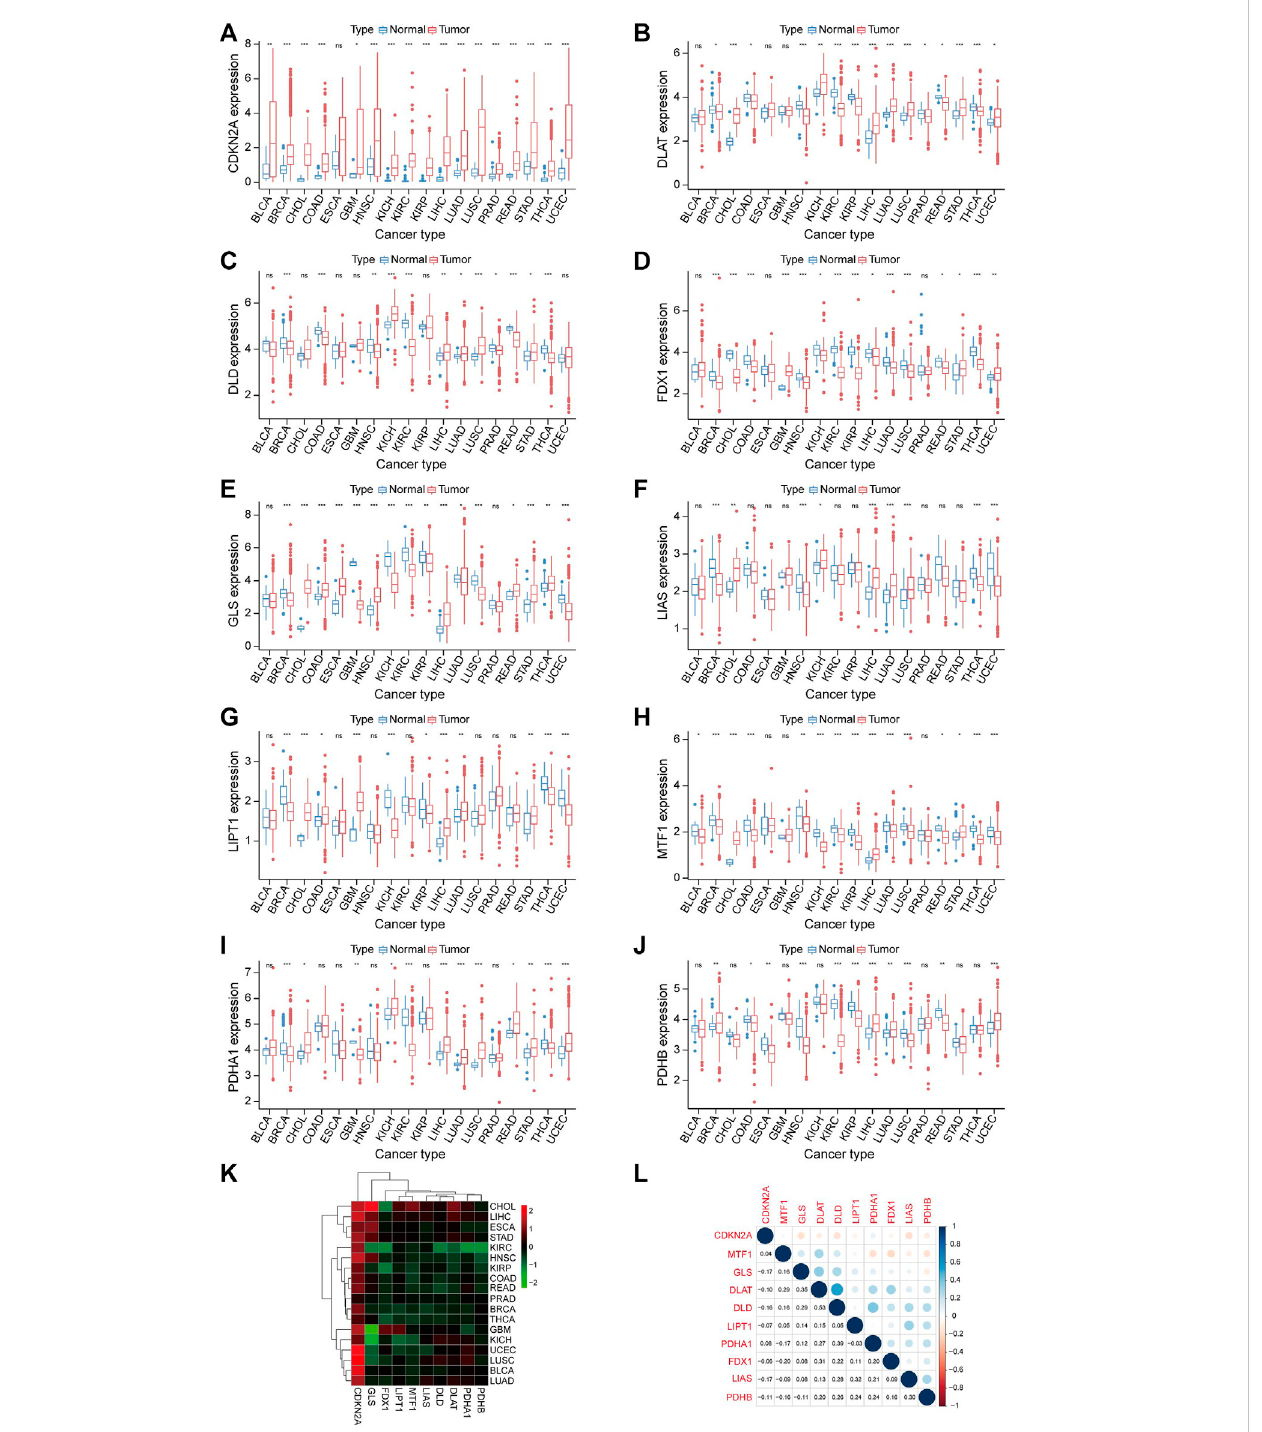
FIGURE 1 Expression analysis of CRGs in Pan-cancer. (A – J) Shows the expression level of 10 CRGs in cancer and normal tissues. Tumor labeled with red color, normal tissue labeled with blue color. * p < 0.05, ** p < 0.01, *** p < 0.001. ( K) The relationship between cancer and the expression level of 10 CRGs is also represented in the heatmap. (L) Correlation between 10